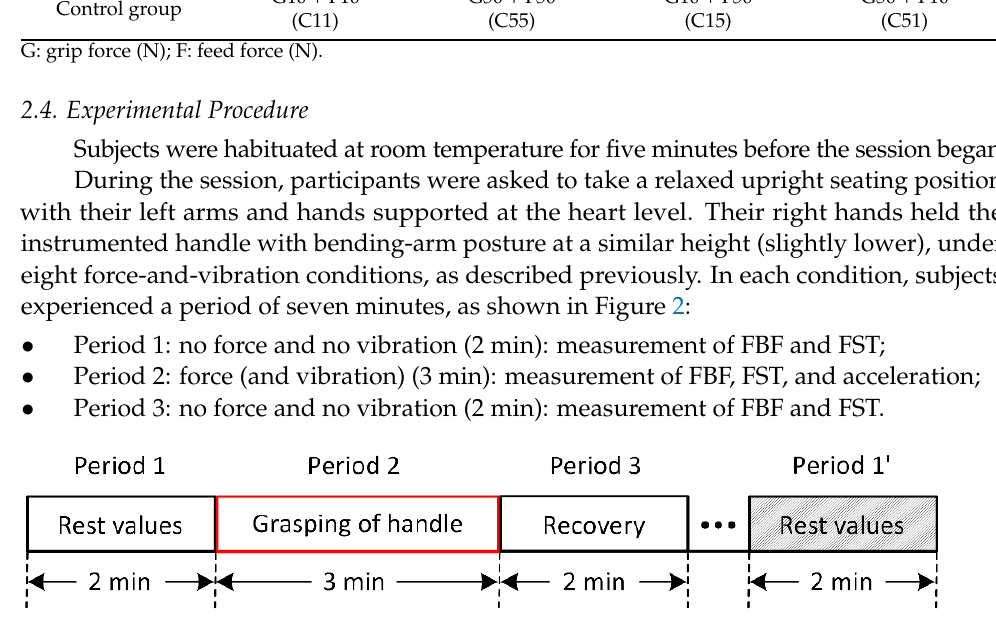
Figure 2. Timeline events during one experimental trial. Subjects experienced various force-and- vibration conditions during period 2 by grasping the handle. Period 1 of the following trial can be regarded as the latter part of the recovery period of the previous round.